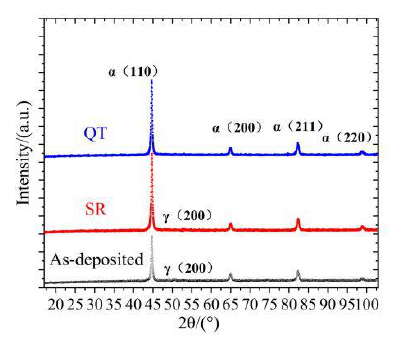
Figure 2. XRD patterns of different states.